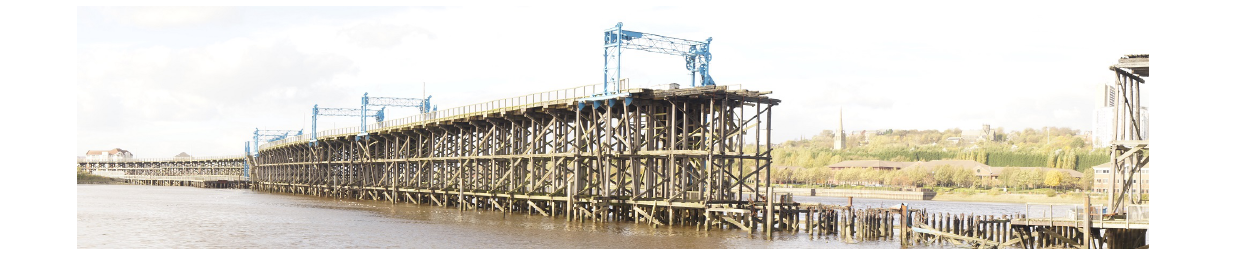
Fig. 1 . View of Dunston Staiths, situated on the River Tyne in the northeast of England. (Source: